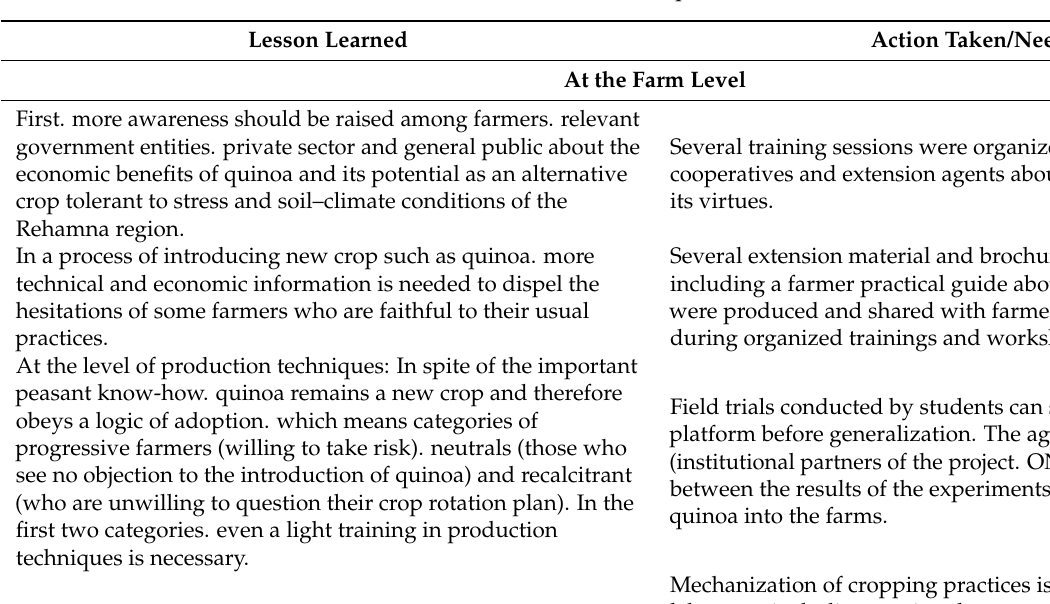
Table 9. Lessons learned from the quinoa value chain in